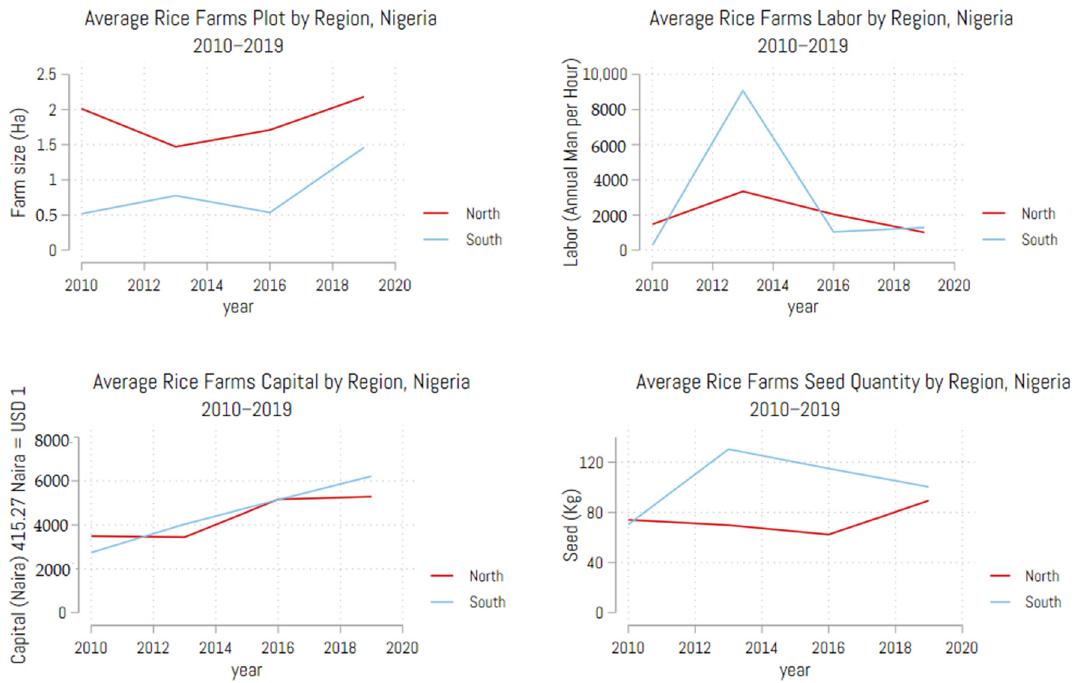
Figure 2. Average rice inputs over time.